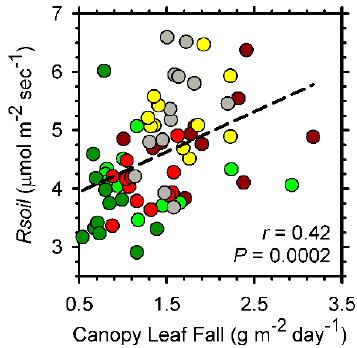
Figure 3. Mean monthly canopy leaf fall and soil respiration ( Rsoil ) correlated positively across all plantations studied ( N = 72, P = 0.0002, r = 0.42). Symbol colors are as in Figure 1. Each symbol is the mean of all measurements from a particular plantation type and month, from 2004 to 2010.